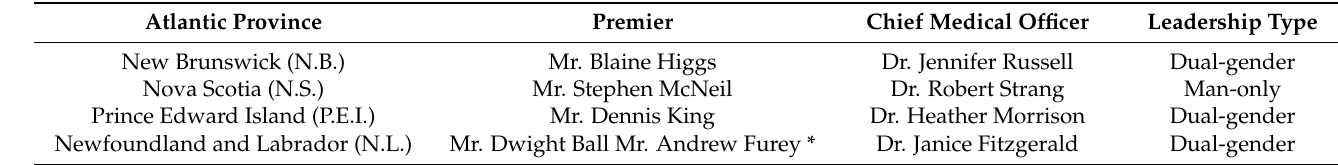
Table 1. Premiers and chief medical officers (CMOs) in Atlantic